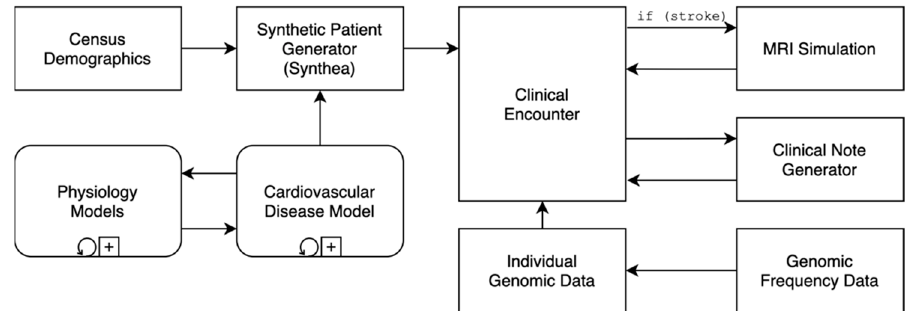
Figure 1. Concept map for the Coherent Data Set. The synthetic patient generator takes census de ‐ mographics as input to generate a set of patients. The generator includes a cardiovascular disease model simulating the progression and treatment of cardiovascular disease, which in turn includes a physiology model to simulate the cardiovascular system and produce artifacts such as ECGs. The generator produces patients with a series of clinical encounters. Each clinical encounter may option ‐ ally include MRI images (e.g., if the patient had a stroke), clinical notes, and genomic data (e.g., if a genetic lab panel was